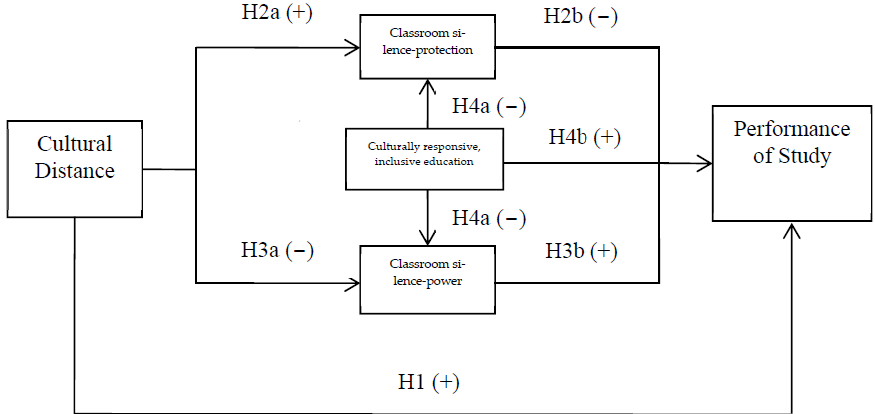
Figure 1. Relationships estimated between cultural distance, classroom silence, CRIE, and perfor- mance of students.